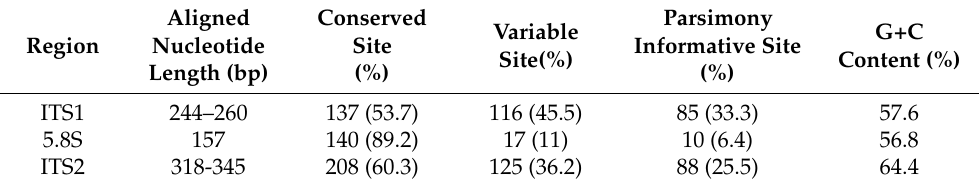
Table 4. Sequence data analysis of ITS1, 5.8S and ITS2 regions in 11 species and three infraspecific taxa of Spathoglottis .